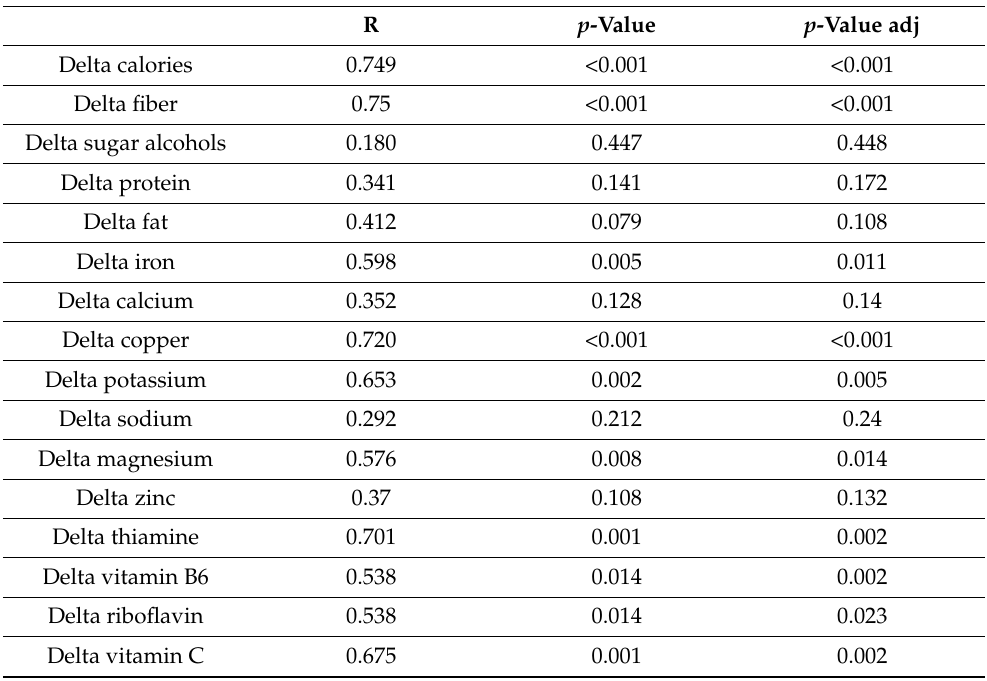
Table 3. Correlations of decreased carbohydrate intake and of decreased protein intake, with changes in consumption of selected macronutrients and micronutrients, as reported in the Food Frequency